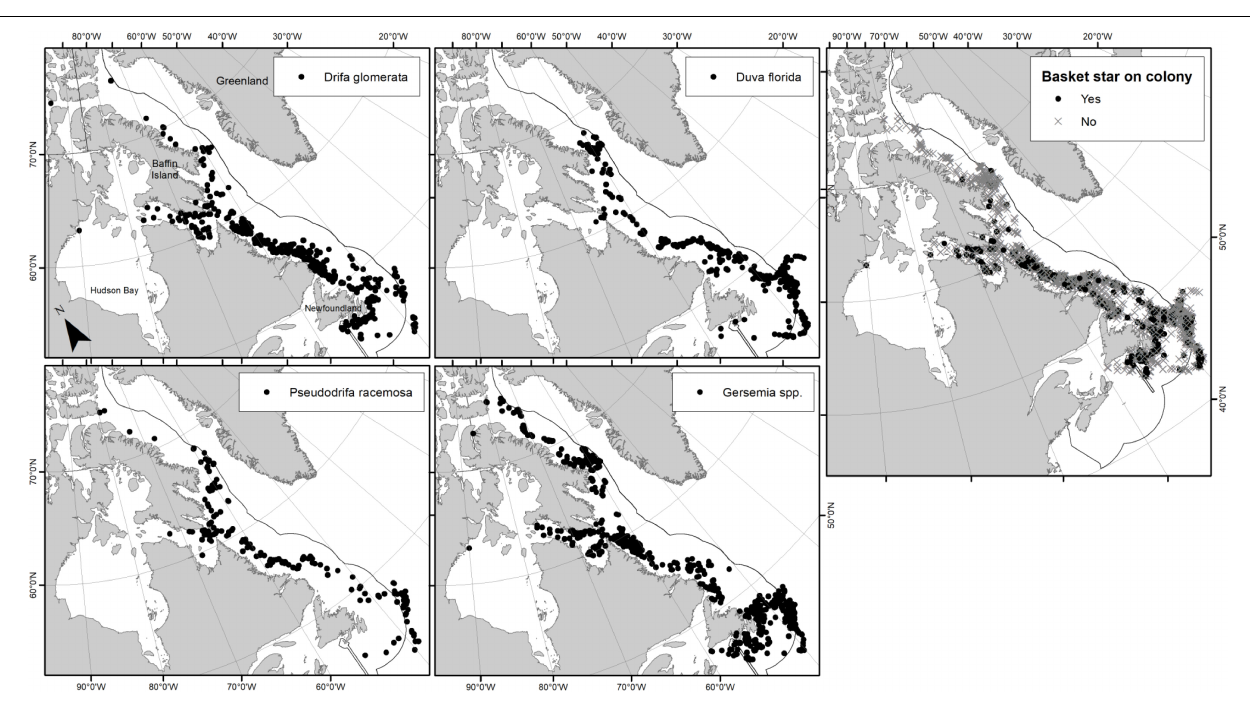
between 53 and 1317 m ( Figure 3 ). Basket stars were present on colonies collected at every month of the year, except for February when 18 sets were deployed between 2005 and 2006 (one